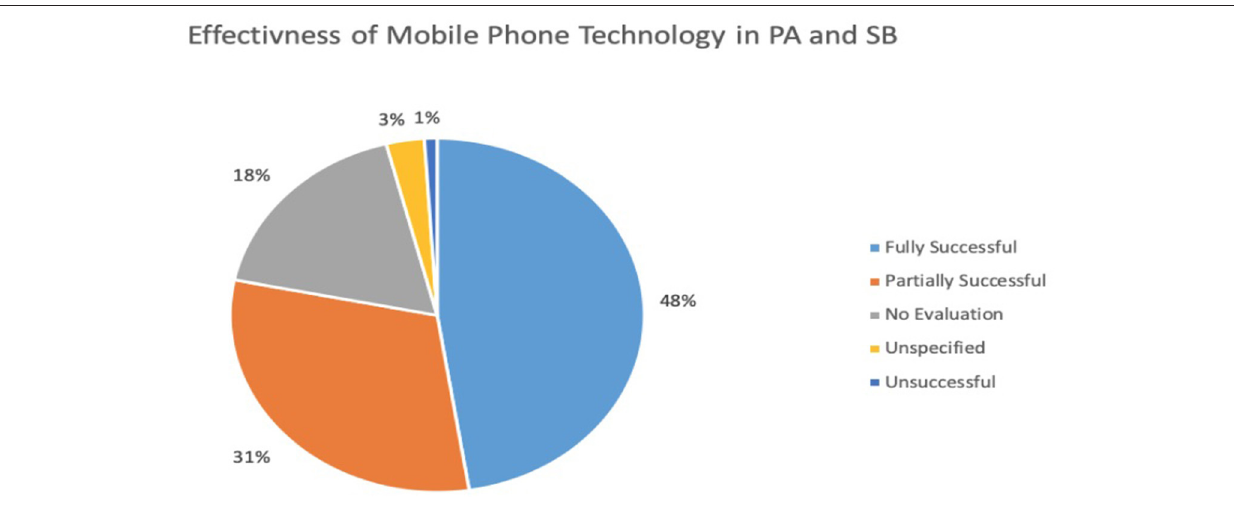
FIGURE 4 | Summary results of mobile phone-based persuasive technology (PT) effectiveness in physical activity (PA) and sedentary behavior